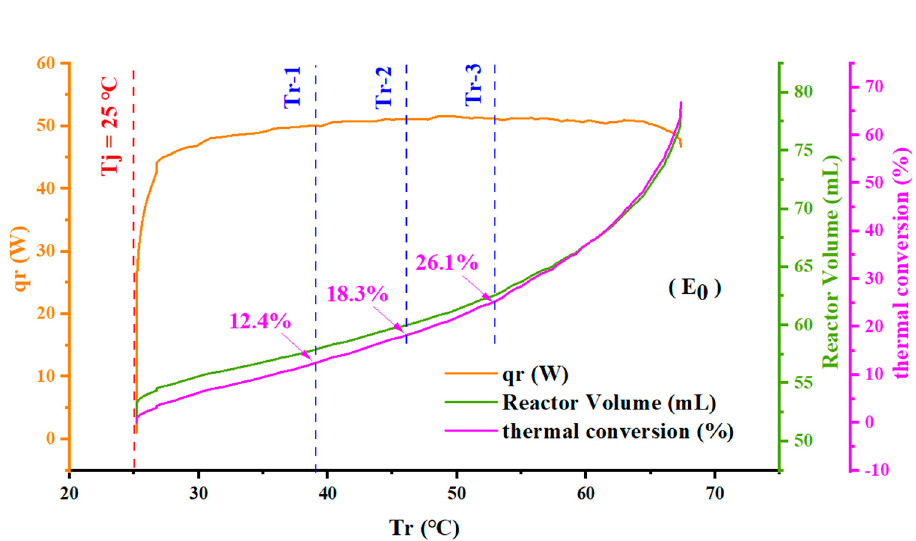
Figure 11. Experimental results of the control experiment E 0 ( T r as the abscissa).